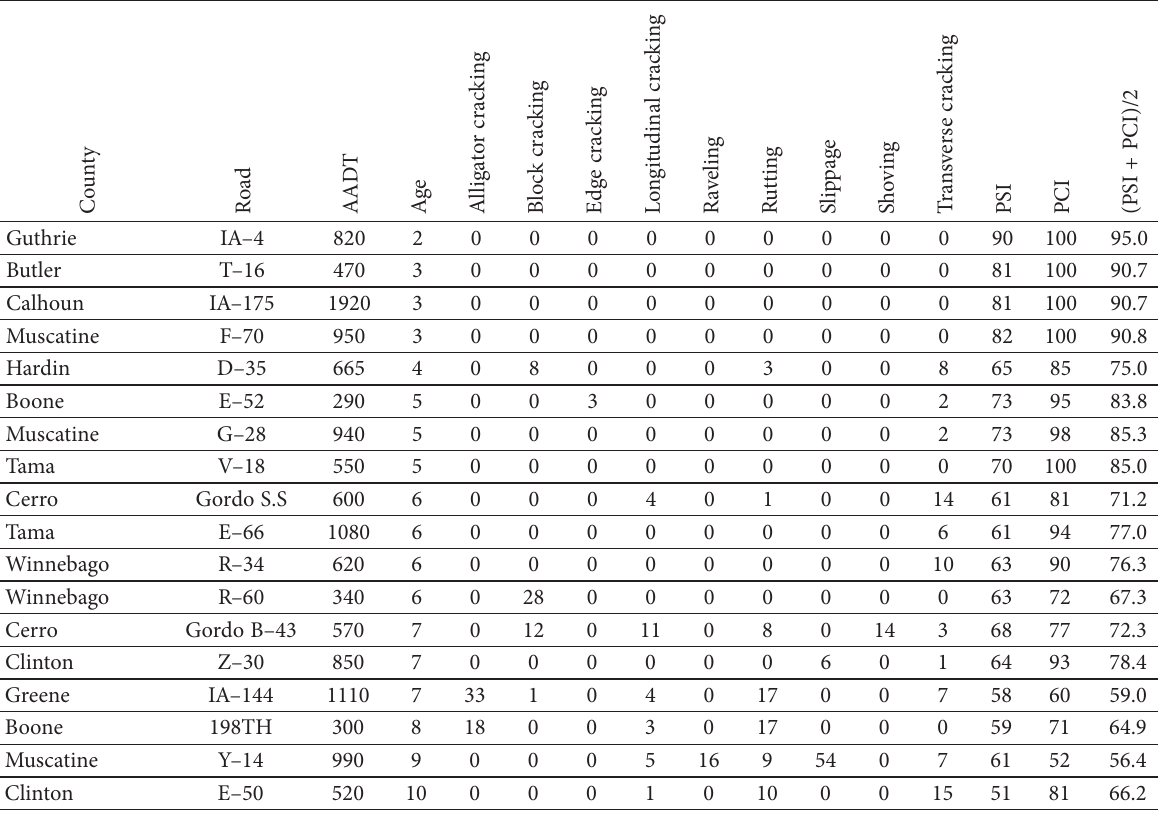
Fig. 13. Effect of adhesion of between layers Table 4. Road surveyed 1996 and 1997 (Jahren et al.